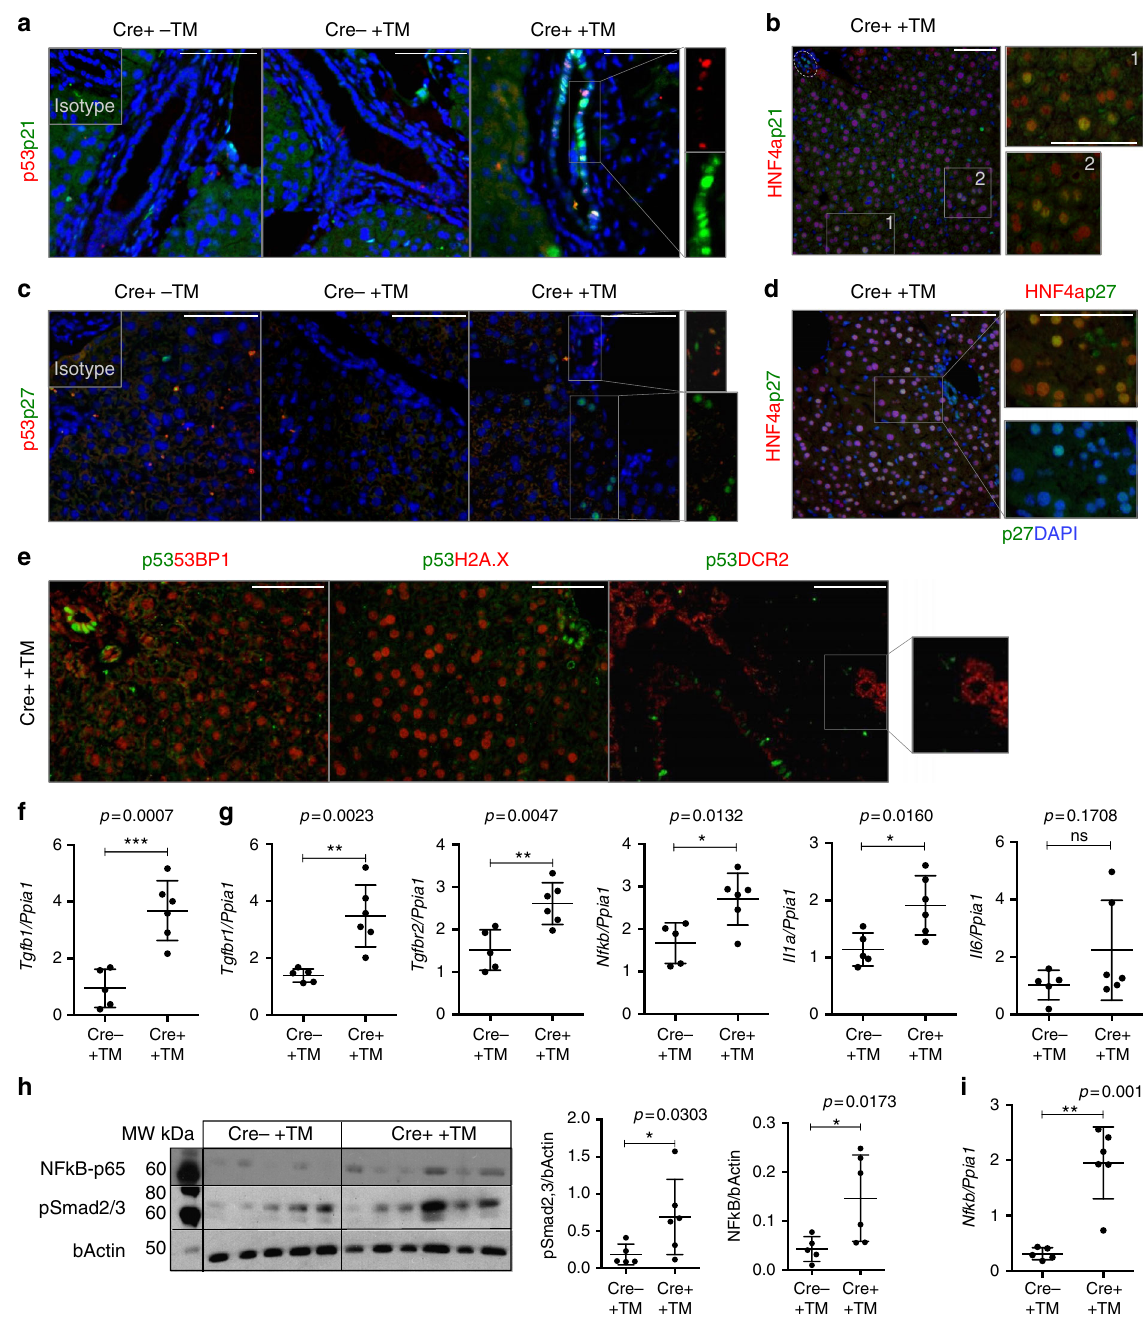
Fig. 3 Paracrine senescence in the model is TGF β -dependent. Mouse data is presented at day 2 after fi nal tamoxifen administration ( N = 6 per group). (Left) K19Cre-positive mice without tamoxifen injection. (Center) K19Cre-negative mice after tamoxifen injection. (Right) K19Cre-positive mice after tamoxifen injection. a p53 (red, indicative of primary senescence events in the cholangiocytes) and p21 (green) co-localize in the bile ducts. However, p21- positive p53-negative cholangiocytes were observed. b p21 (green) co-localizes with HNF4 α -positive hepatocytes (red). c p27 (green) colocalizes with p53-positive cholangiocytes (red). p27 is expressed in cholangiocytes and hepatocytes in a paracrine manner. d p27 (green) co-localizes with HNF4 α - positive hepatocytes (red). e Markers of senescence (such as 53BP1, H2A.X and DCR2, in red) are expressed in cholangiocytes and liver parenchyma, while expression of p53 (green) is restricted to the cholangiocytes. Single channels for this fi gure are provided in Supplementary Fig. 8a. Scale bars = 50 µ m. f qRT-PCR analysis of Tgfb1 in the isolated bile ducts of Cre − + TM ( N = 5) and induced Cre + + TM ( N = 6) K19-Mdm2 fl ox/ fl ox tdTom LSL mice day 2 after induction. *** denotes p < 0.005 (Mean ± SEM). Mann − Whitney test. g Analysis of common SASP ’ s factors by qRT-PCR (from left to right, Tgfbr1 , Tgfbr2 , Nfkb , Il1a and Il6 ). * denotes p < 0.05, ** p < 0.01 (Mean ± SEM). Mann − Whitney test. h Western blot of phospho-NF- κ B-p65 and pSmad2/3. Each band represents the bile ducts isolated from one mouse. Blots are companied by at least one marker position (molecular weights MW, in kDa). Far right, western blot densitometry quanti fi cation (normalized to bActin control) show increased expression of NF- κ Bp-65 and pSmad2/3 after induction of the model. * denotes p < 0.05 (Mean ± SEM). Mann − Whitney test. i qRT-PCR of Nfkb in hepatocytes isolated from Cre − and Cre + K19-Mdm2 fl ox/ fl ox tdTom LSL mice at day 2 after last tamoxifen administration ( N = 5-6 per group). ** denotes p < 0.01 (Mean ± SEM). Mann − Whitney